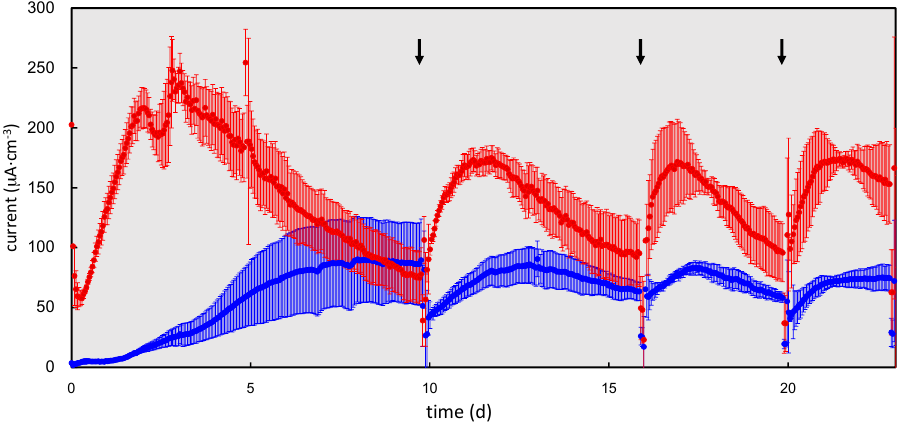
Figure 2. The production of electricity from sewage wastewater using the rGO and GF complexes. The data shown represent the average values of three independent experiments performed in parallel. The arrows indicate when the wastewater in the bottles was replaced. The error bars are standard errors from three independent experiments.